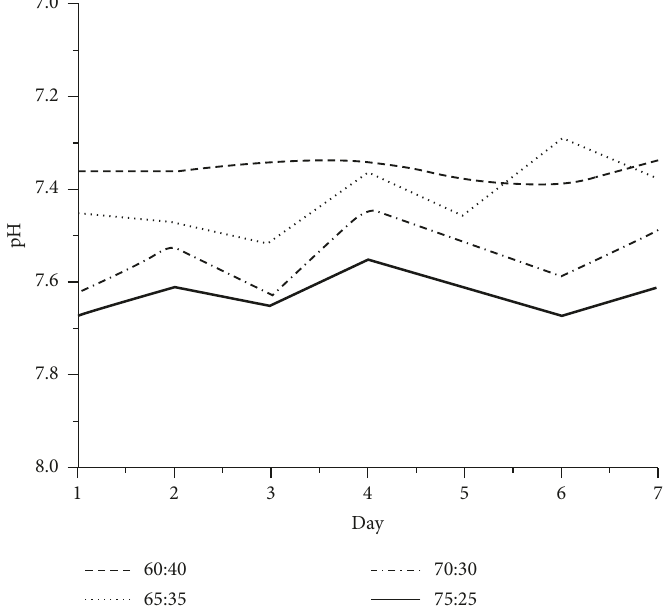
Figure 6: The acidity stability of the IBS sample with several HA:GEL